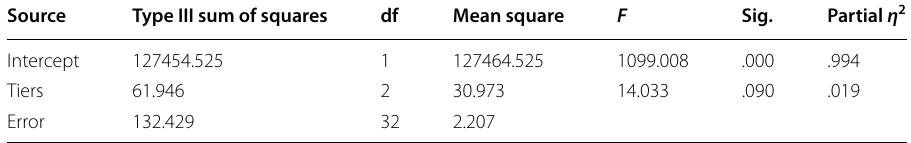
Table 6 Test of between-subject effects in collaborative group Source Type III sum of squares df Mean square Sig. Intercept Tiers